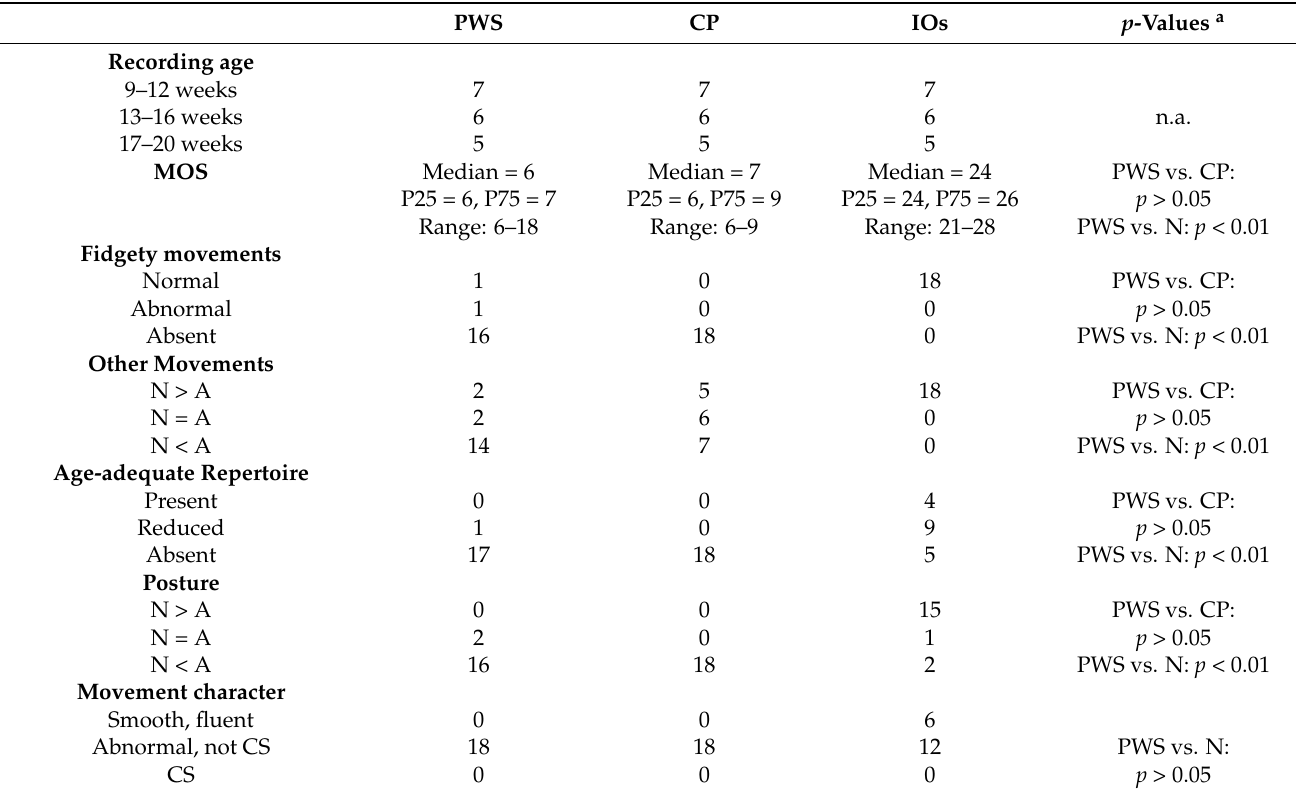
Table 2. The motor optimality score (MOS) and its subcategories in infants diagnosed with PWS, those with cerebral palsy (CP), and in infants with later inconspicuous developmental outcomes (IOs). Each group had 18